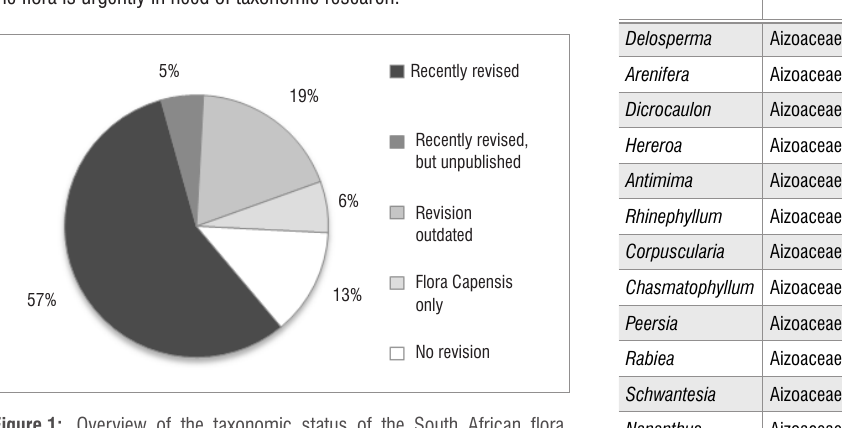
Figure 1: Overview of the taxonomic status of the South African flora, showing the proportion of taxa (species and subspecific ranks) that have been recently revised, those with outdated (older than 1970) revisions, those not treated since the Flora Capensis series and those with no revision.